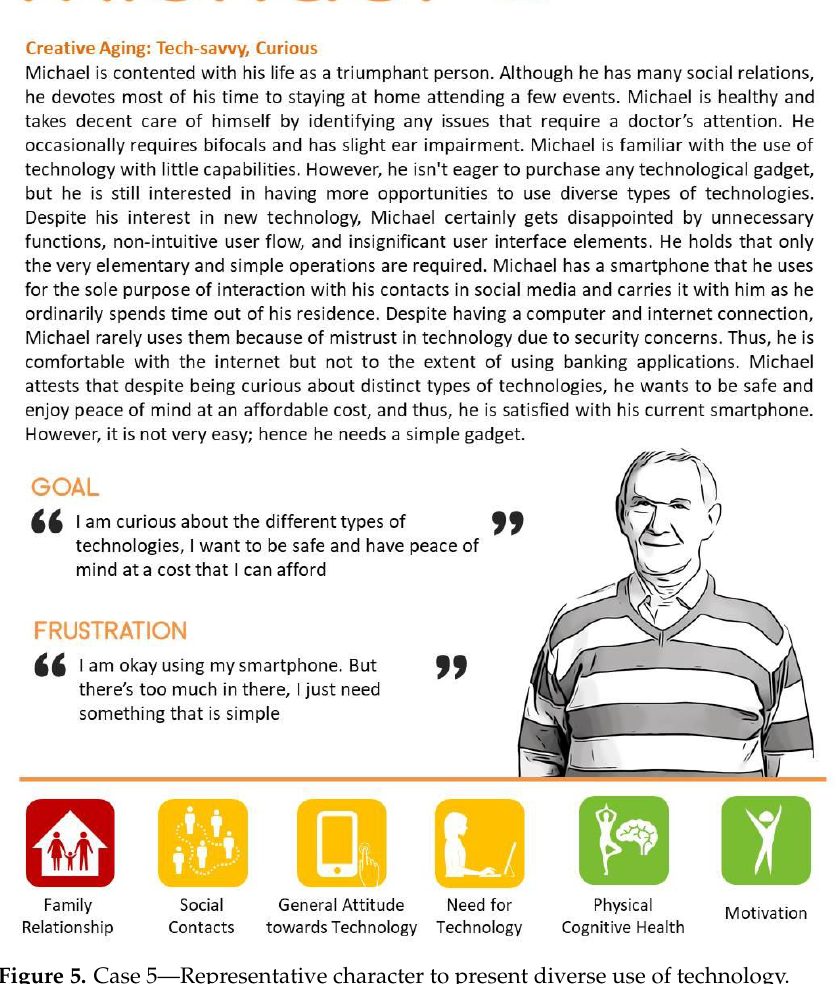
Figure 5. Case 5—Representative character to present diverse use of technology.